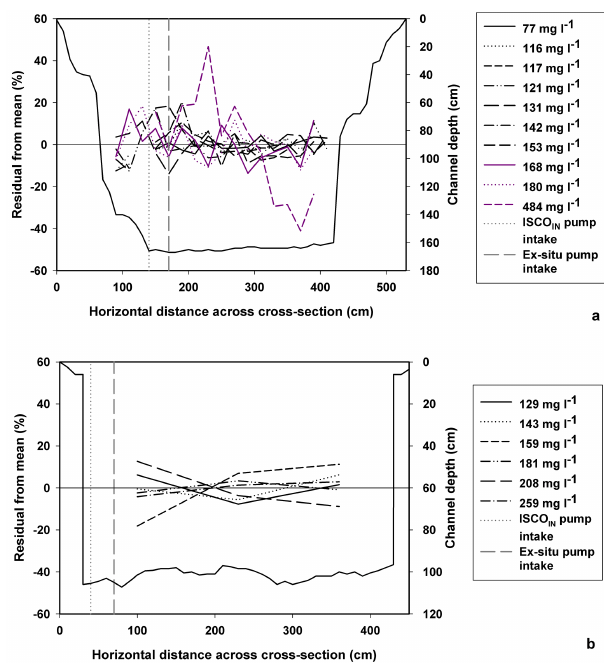
Figure 5. Variability of instantaneous depth-integrated SSC mea- surements across the channel cross section compared to the mean transect SSC using a US DH-48 sediment sampler at (a) Grassland B and (b) Arable